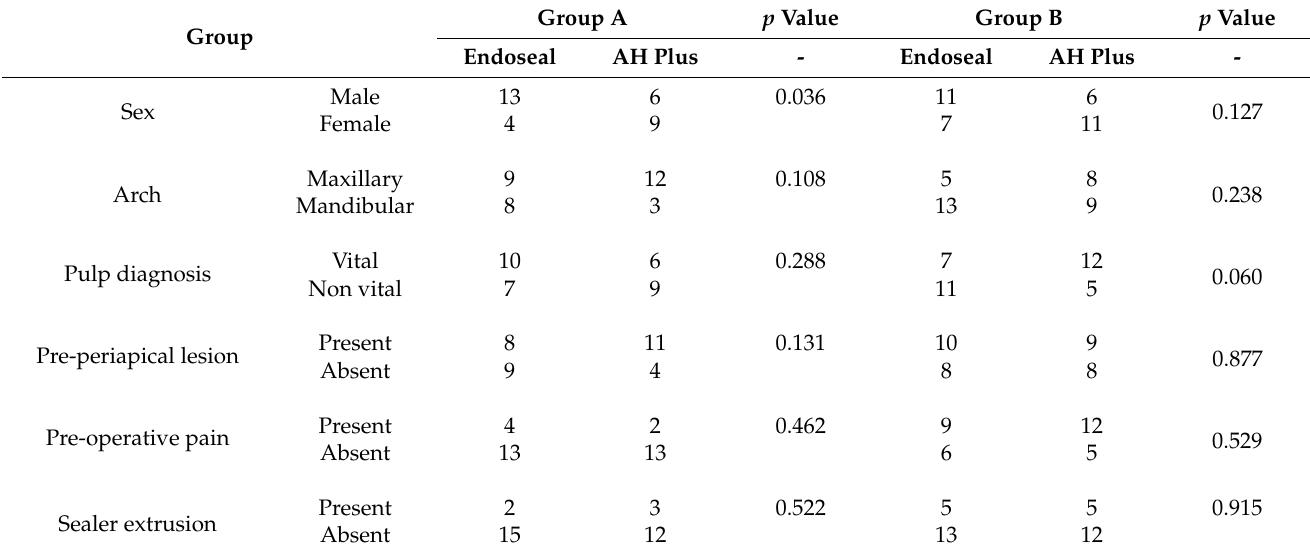
Table 1. Baseline clinical characteristics of the study groups. Chi-squared p value is presented. Group Group